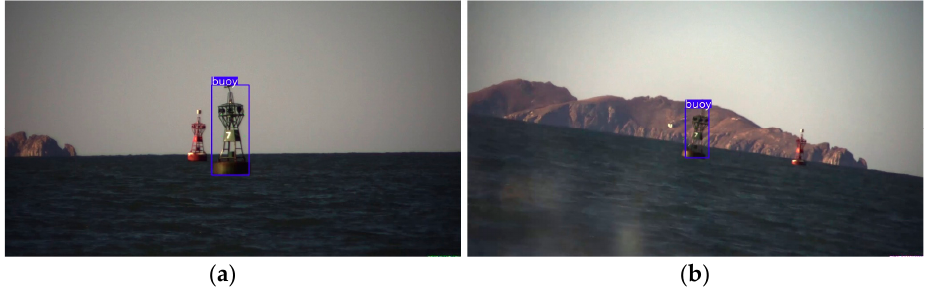
Figure 15. Extraction results for the multi-buoy case: ( a ) Test results in a simple background; ( b ) Test results in a complex background.